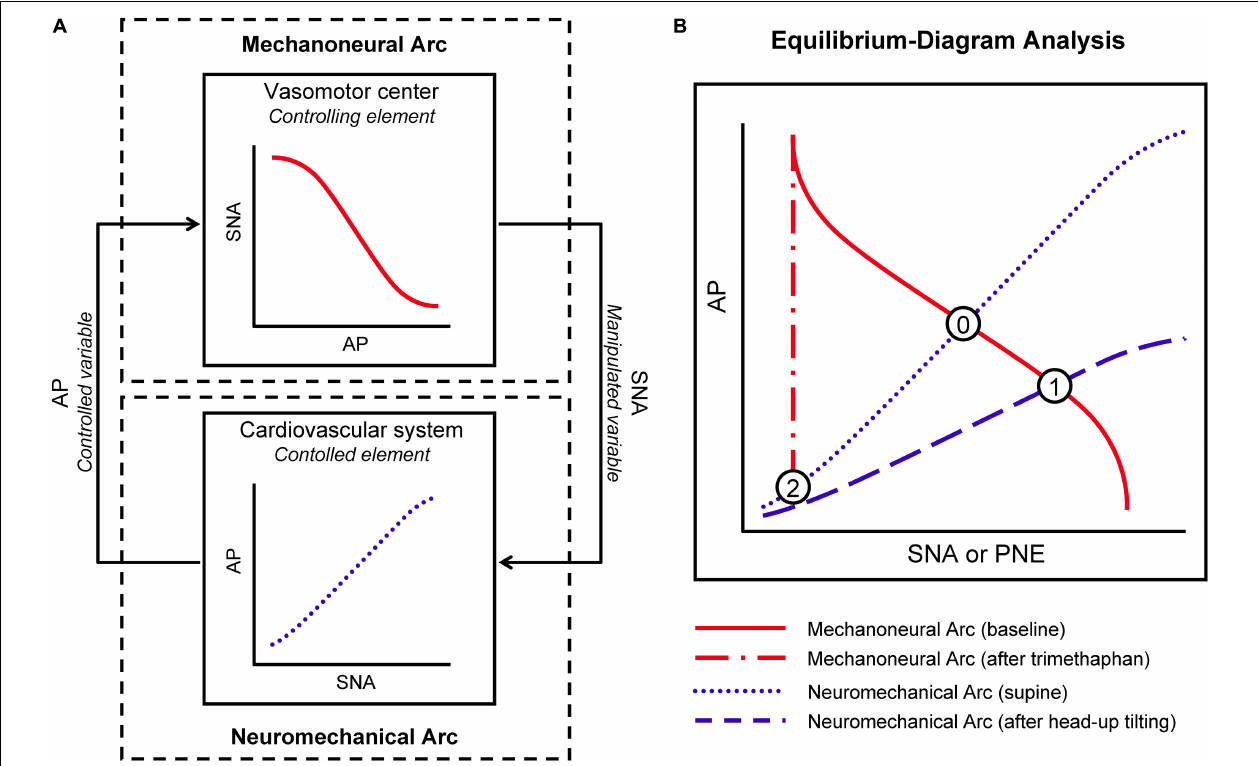
FIGURE 1 | Conceptual scheme for integrative analysis of human sympathetic arterial baroreflex. Sympathetic arterial baroreflex is a feedback control system, which is divided into mechanoneural (MN) and neuromechanical (NM) arcs (A) . In the MN arc, its input is a controlled variable, arterial pressure (AP), and its output is a manipulated variable, sympathetic nerve activity (SNA); in the NM arc, its input and output are SNA and AP, respectively. The functional curves of the two arcs can be superimposed on an equilibrium diagram (B) . Under closed-loop conditions of the feedback system, its operating point should be a point of intersection between the two curves. PNE, plasma norepinephrine level. See text for detailed explanation of Points 0, 1, and 2